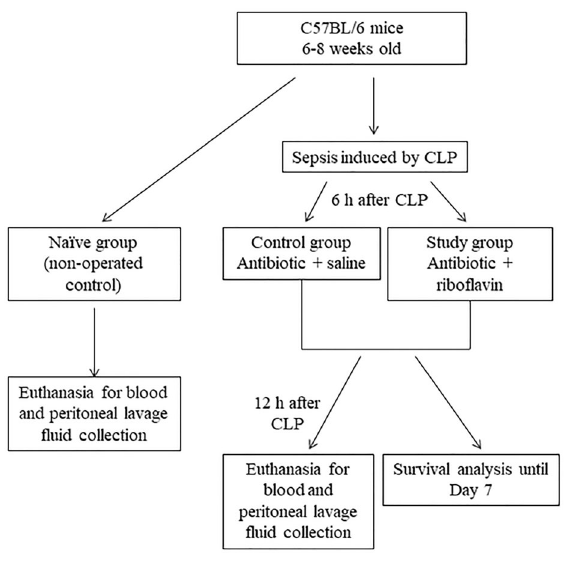
Figure 1. Flow diagram of the study. CLP: cecal ligation and